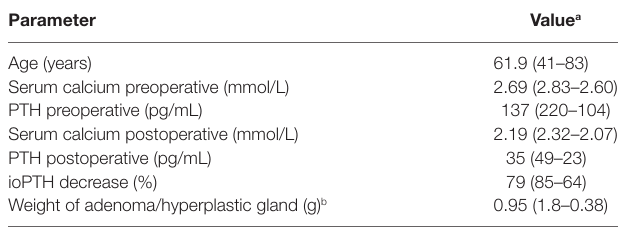
TaBle 1 | Characteristics of the patients. Parameter Value